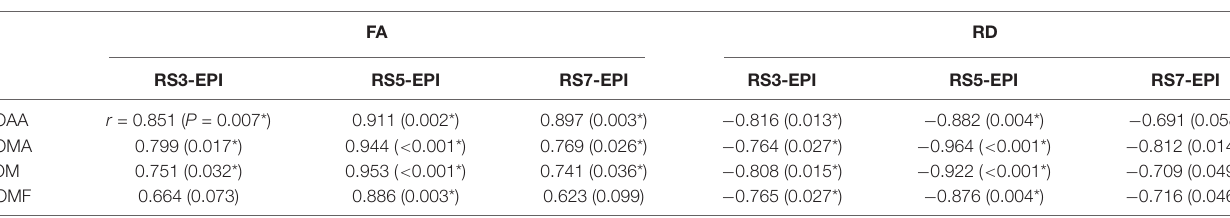
FIGURE 5 | Box plot comparing FA, RD, and DTT fiber numbers for RS3-EPI, RS5-EPI, and RS7-EPI. RS5-EPI yielded higher FA and lower RD than RS3-EPI and RS7-EPI (A,B) . The DTT fiber number generated by RS5-EPI was significantly higher than RS3-EPI (C) . ** P ≤ 0.017, post hoc analysis with Bonferroni corrected. TABLE 3 | Correlation coefficients between DTI parameters and histopathological